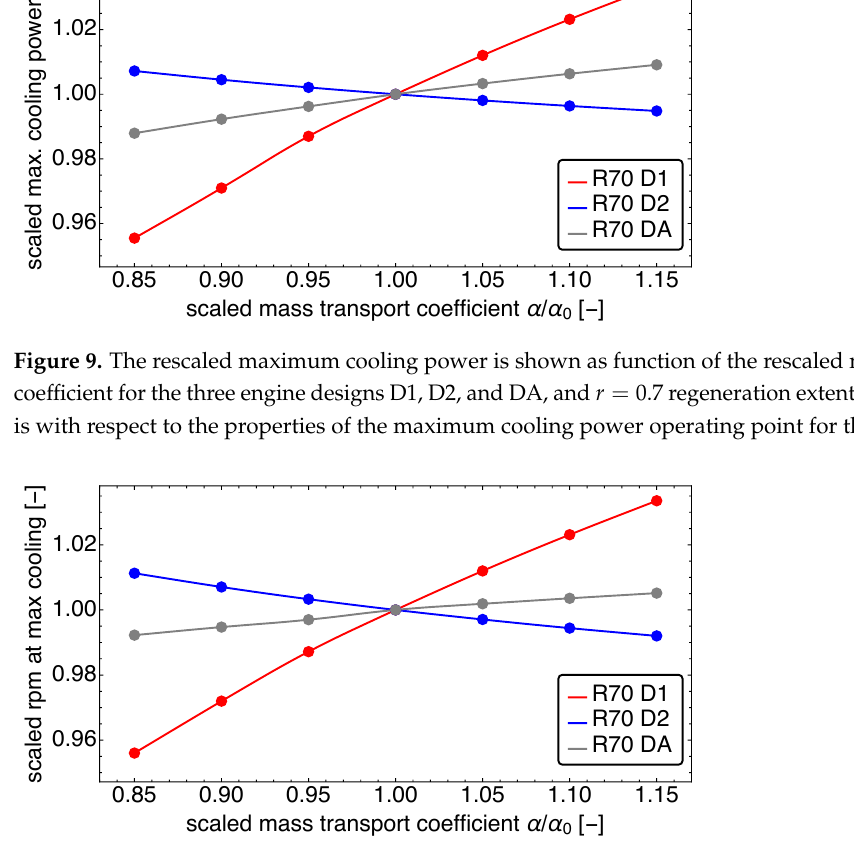
Figure 10. The rescaled engine speed at maximum cooling power is shown as function of the rescaled mass transport coefficient for the three engine designs D1, D2, and DA, and r = 0.7 regeneration extent. The rescaling is with respect to the properties of the maximum cooling power operating point for the base case.